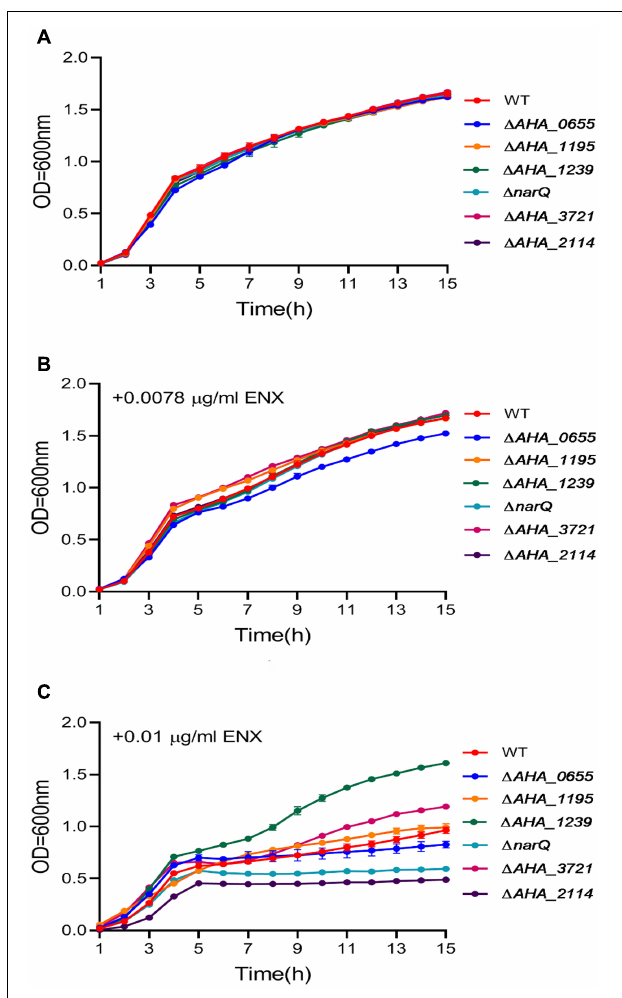
FIGURE 5 | The Growth curves of A. hydrophila WT and a total six gene deletion strains with or without ENX treatment. (A) LB medium alone; (B) LB medium + 0.0078 µ g/mL ENX; (C) LB medium + 0.01 µ g/mL